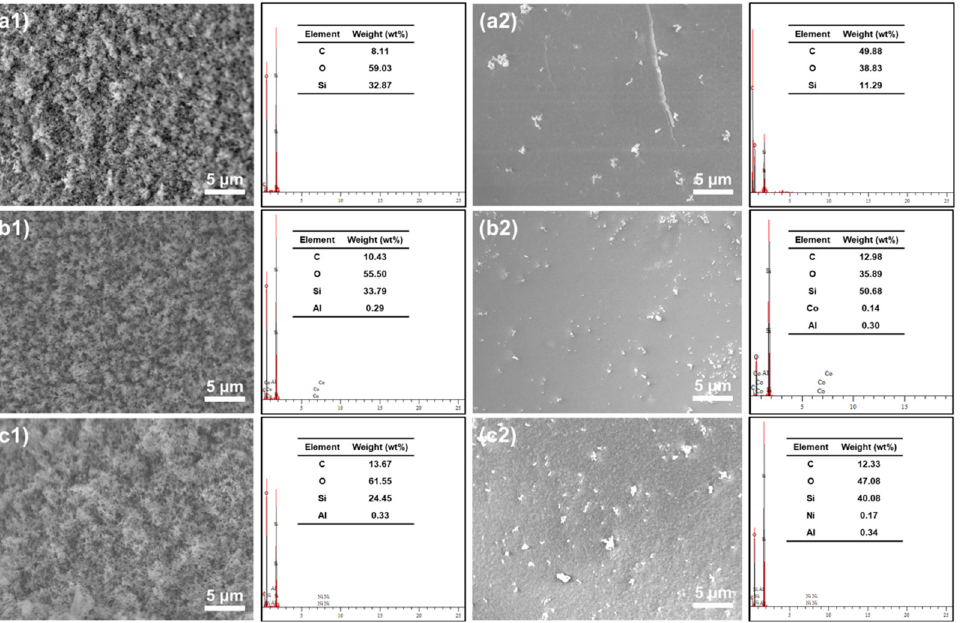
Figure 7. SEM-EDS images of the outer surface (SiF: a1 ; SiF/CoAl-LDH-1.0: b1 ; SiF/NiAl-LDH-1.0: c1 ) and inner surface (SiF: a2 ; SiF/CoAl-LDH-1.0: b2 ; SiF/NiAl-LDH-1.0: c2 ) of char residues from the nanocomposites after vertical flame testing.